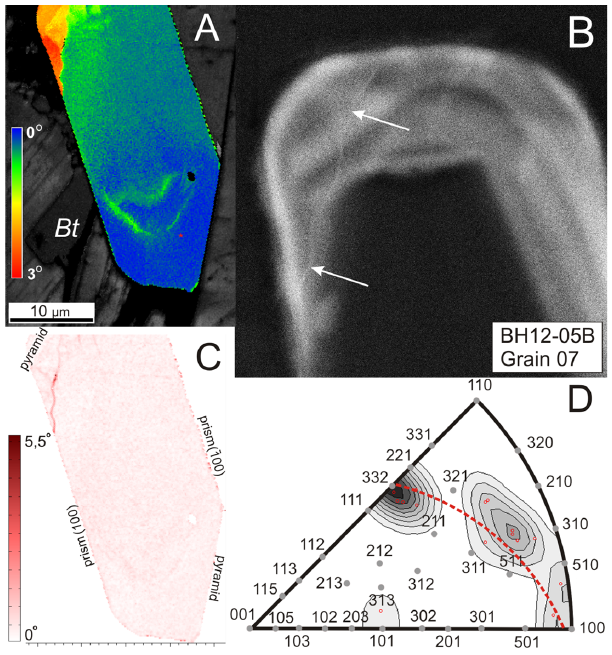
Figure 3. Grain BH12-05B_07, lattice distortion type (III) case 1. (a) EBSD map color-coded for zircon misorientation with respect to a reference point (red star marker); Bt: biotite. (b) Detailed CL image of the upper part of the grain; bright trace (marked by white arrows) corresponds to subgrain boundary. (c) EBSD map of zir- con that shows the orientation changes between neighboring data points (“local misorientation”); labels indicate families of crystallo- graphic faces. (d) Inverse pole figure plot of the misorientation axes distribution density comprising the positions of misorientation axes (small red circles), crystallographic directions (grey dots) and the great circle formed by the misorientation axes (dashed red line).